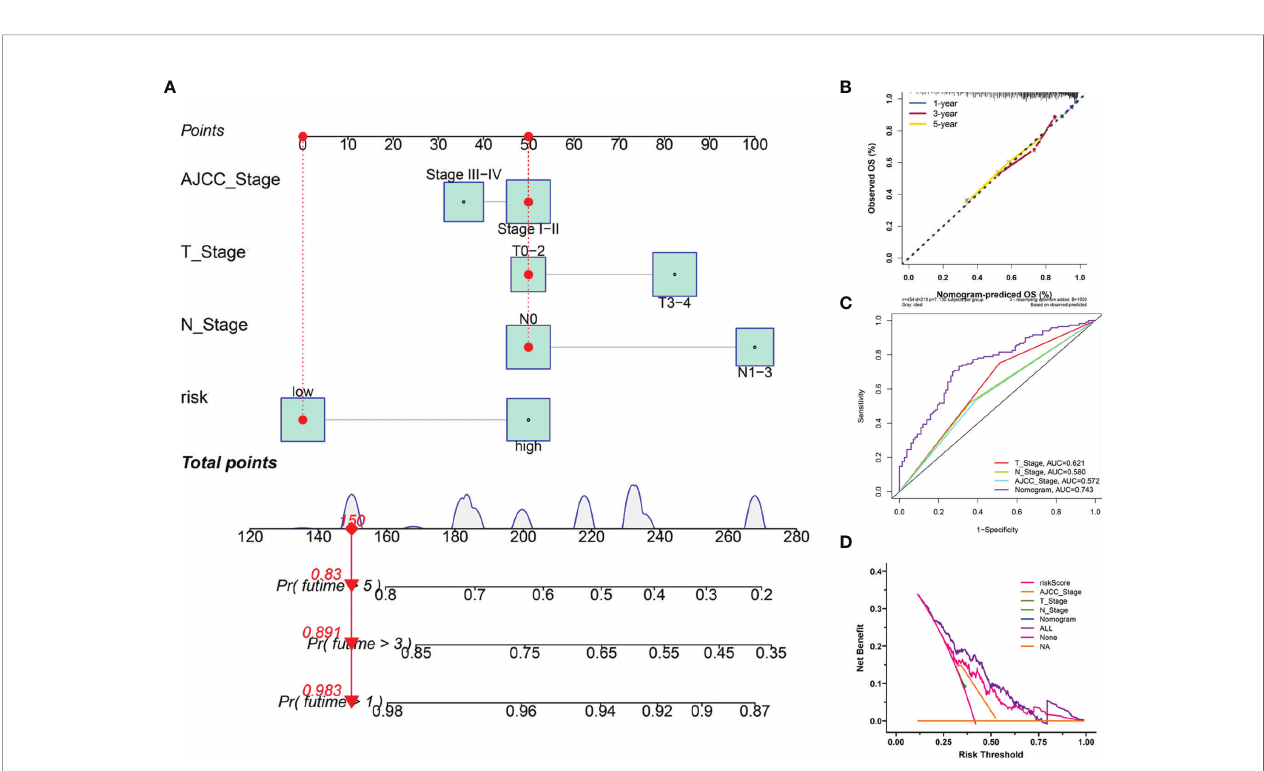
FIGURE 7 | Construction and evaluation of the novel nomogram. (A) The nomogram for predicting the survival probability of SKCM patients has four independent prognostic features. (B) The calibration plots of the nomogram for predicting OS probability for 1-, 3-, and 5-years. (C) ROC analysis of the nomogram. (D) DCA of the